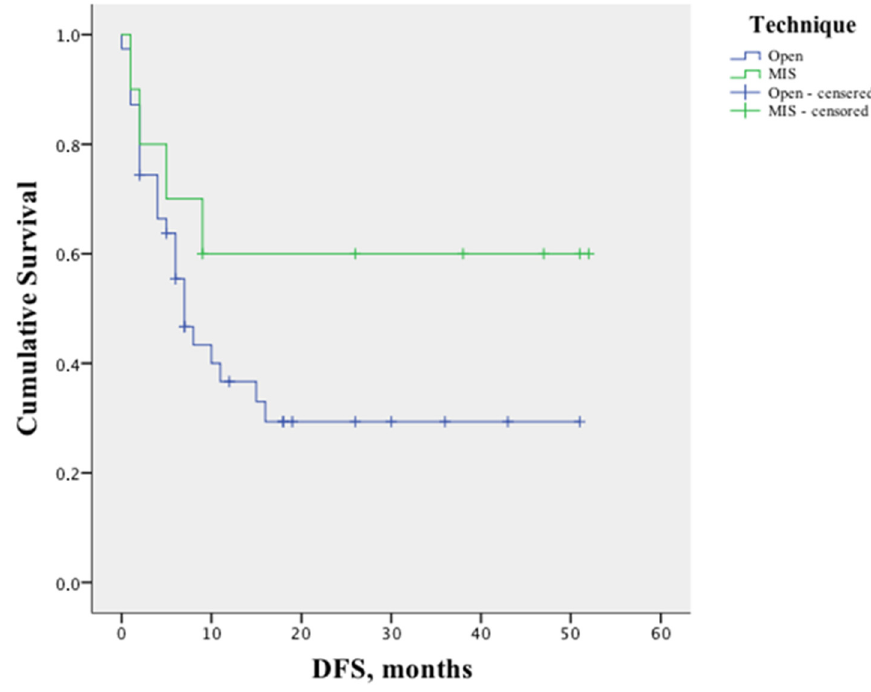
Figure 4. Kaplan–Meier curve of disease-free survival (DFS) ( p = 0.164) stratified by technique of liver